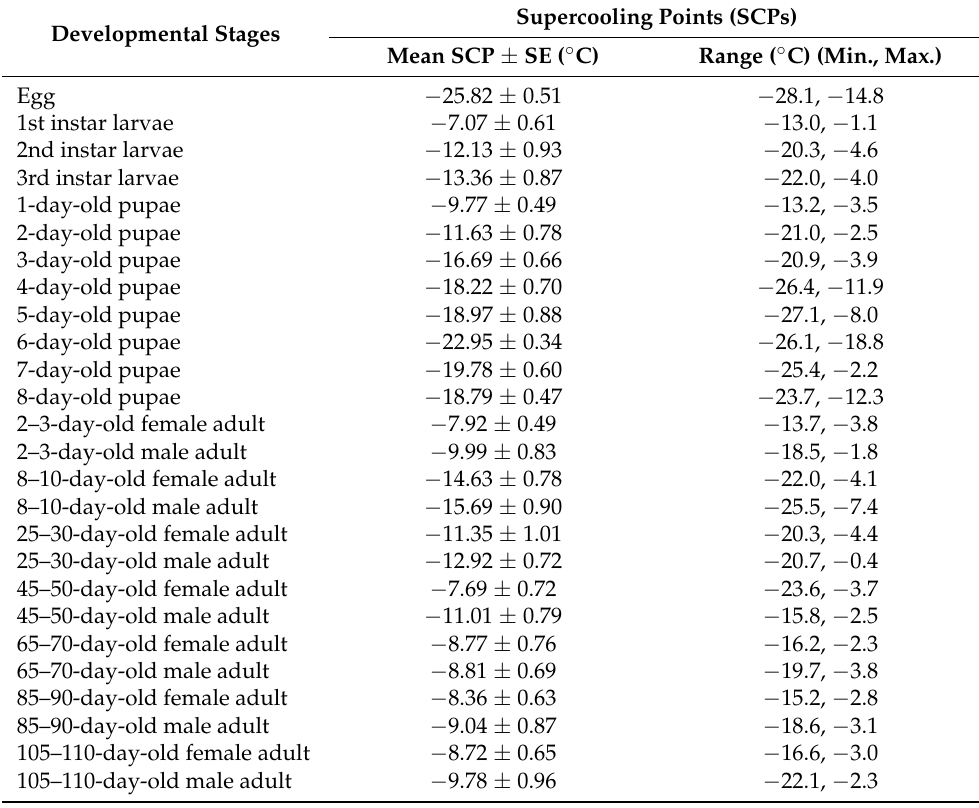
Table 1. Mean supercooling point for different developmental stages of Bactrocera tau